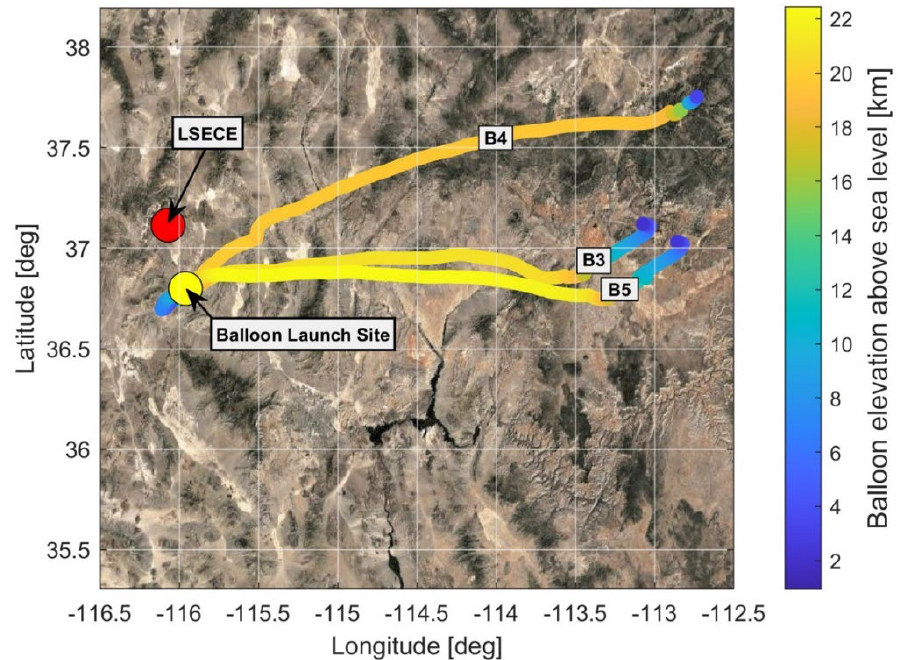
Figure 2. Balloon flight tracks on 29 October. Balloons 3, 4, and 5 are denoted with the B3, B4, and B5 labels, respectively. Balloon 2 is not shown because it suffered a mechanical failure. The map was generated using Google Maps and a modified version of the MATLAB code written by Bar-Yehuda [24].